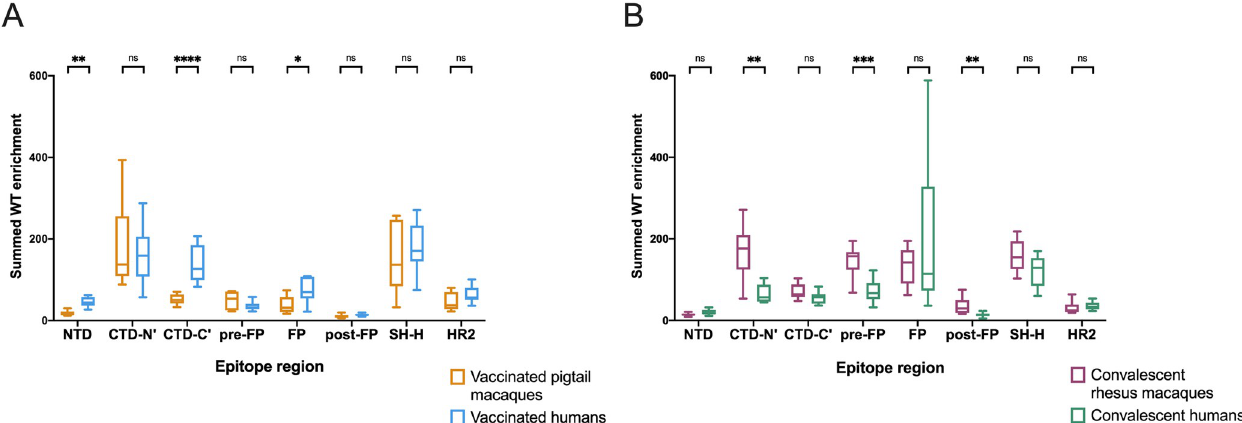
Fig 2. Differences in enrichment of wildtype peptides by group. For each individual, wildtype enrichment values were summed for all peptides within each epitope region. Boxplots summarize the data for all individuals in each sample group. The box represents median and interquartile range (IQR), the lower whisker represents the lowest data point above Q1-1.5IQR, and the upper whisker represents the highest data point below Q3+1.5IQR. (A) compares vaccinated pigtail macaques to vaccinated humans, while (B) compares convalescent rhesus macaques to convalescent humans. Multiple Mann-Whitney U tests were performed, with p values corrected for the number of comparisons in each plot (8) using the Bonferroni-Dunn method. ���� , p � 0.0001; ��� , p � 0.001; �� , p � 0.01; � , p � 0.05.